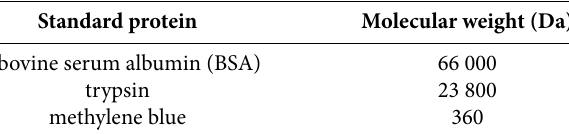
Table 2. Molecular weights of standards Standard protein